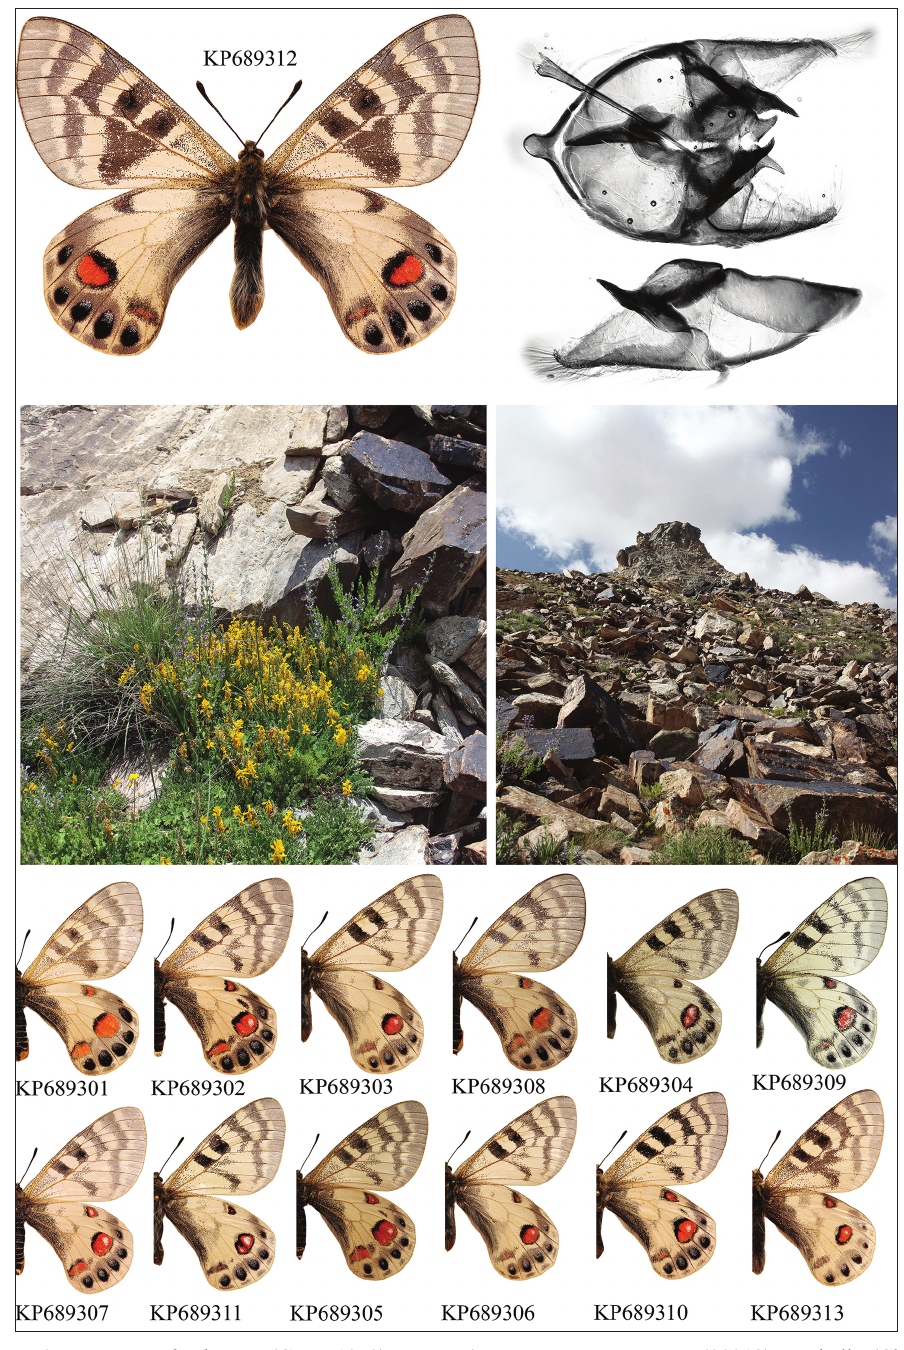
Figure 4. Koramius charltonius (Gray, 1853). Imago ( mistericus , paratype, KP689312 ), genitalia (Chitral, Baroghil Pass), host-plant ( Corydalis gortschakovii ), habitat (Tajikistan, West Pamirs, 35–45 km N of Khorog, the type locality of safronovi ) and sequenced